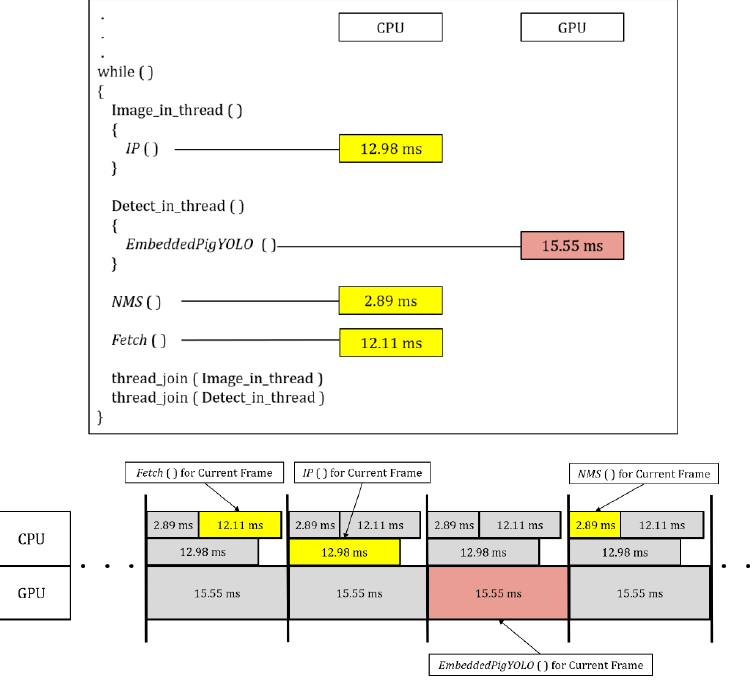
Figure 8. Illustration of the code structure for a pipelined execution and execution times of each step on a